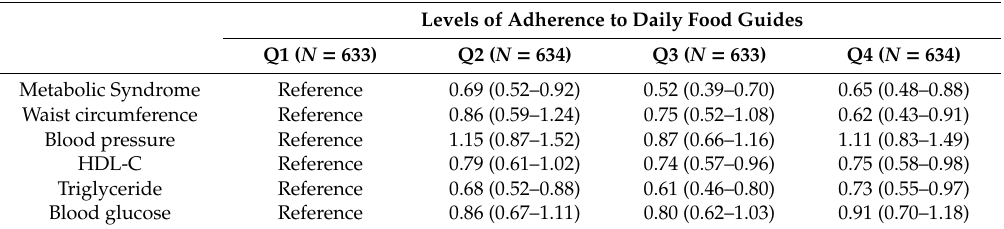
Table 3. Associations of levels of adherence to overall daily food guide scores with the risk of having abnormal metabolic syndrome indices or metabolic syndrome.